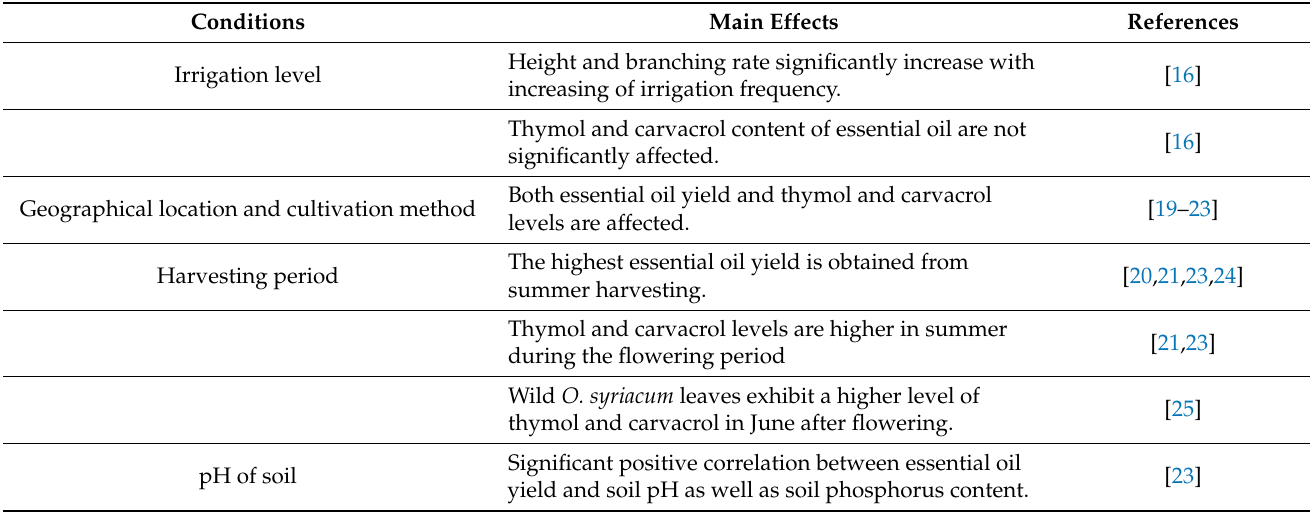
Table 3. Effects of pre-harvesting conditions of Origanum syriacum .